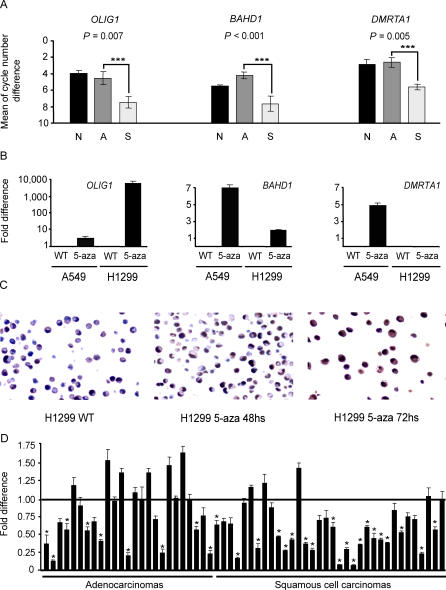
Real-Time PCR Analysis of Three Differentially Methylated Genes in Adenocarcinomas, SCCs, and Lung Cancer Cell Lines
OLIG1 immunohistochemistry in H1299 cells and OLIG1 deletion analysis.(A) Real-time PCR data for OLIG1, BAHD1, and DMRTA1 normalized to the expression of CAMKK2. The error bars indicate the standard deviation of nine different measurements per gene. The value for normal lung was established by taking the average mRNA expression of three different samples so as to try to capture the potential variability in the normal expression of each of the genes. ***; significant at the 97.5% confidence level; N, normal lung; A, adenocarcinoma; S, SCC.(B) OLIG1, BAHD1, and DMRTA1 mRNA expression in A549 and H1299 cell lines treated with 1 μM 5-aza-dC for 72 h. The error bars indicate the standard deviation of nine individual measurements.(C) OLIG1 immunohistochemistry on untreated and 1 μM 5-aza-dC treated H1299 cells. Treatment times are indicated underneath each panel. Photographs were taken at 400× magnification.(D) OLIG1 DNA level for adenocarcinomas and SCCs. Each bar represents one sample. The error bars indicate the standard deviation of three independent measurements. Samples for which the level of OLIG1 DNA was significantly lower than that of its matching tumor-free lung DNA (p < 0.050, one-tail Student's t-test) are indicated with a star.